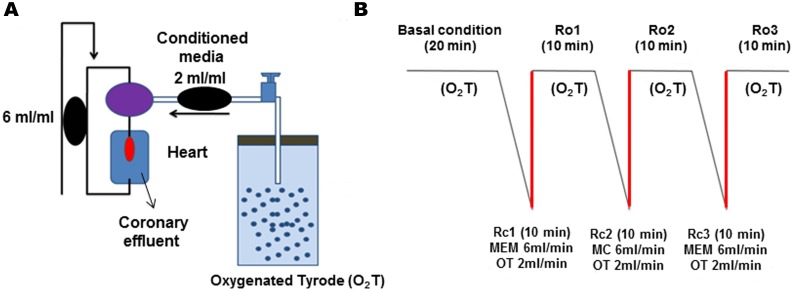
(A) Perfusion circuit with recirculation/ reoxygenation.The black ovals represent the two peristaltic pumps used to perfuse solutions. The magenta oval represents the device on which the cannula is inserted to perfuse the heart and red oval represents the heart. The black lines show the connections that allow the entry of oxygenated solution (O2T) in the heart. (B) Protocol of recirculation/reoxygenation. Rc: Recirculation and Ro: Reoxygenation. The red and diagonal black lines indicate the parallel perfused Conditioned medium or MEM.